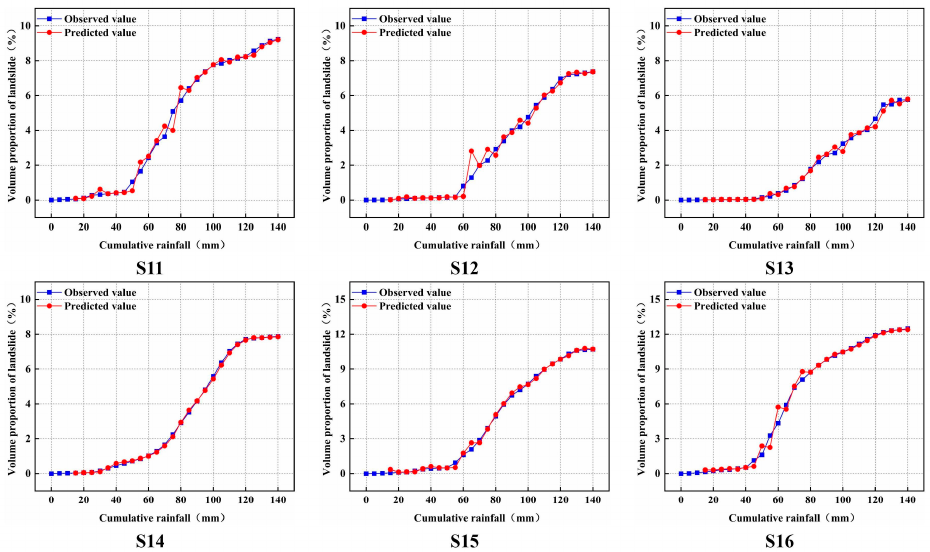
Figure 6. S-growth curve model prediction results (S11–S16).